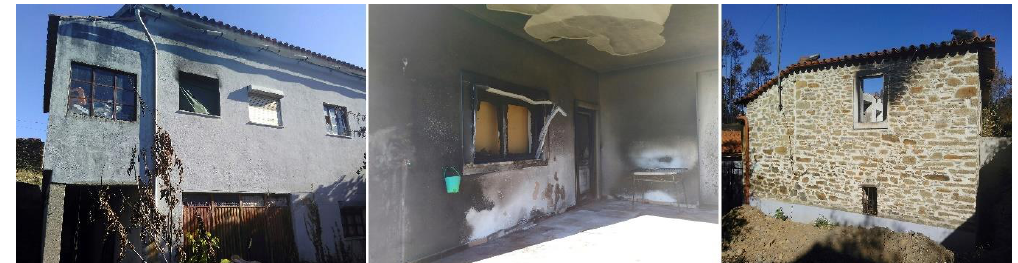
Figure 8. Example of houses that had ignitions through the windows.